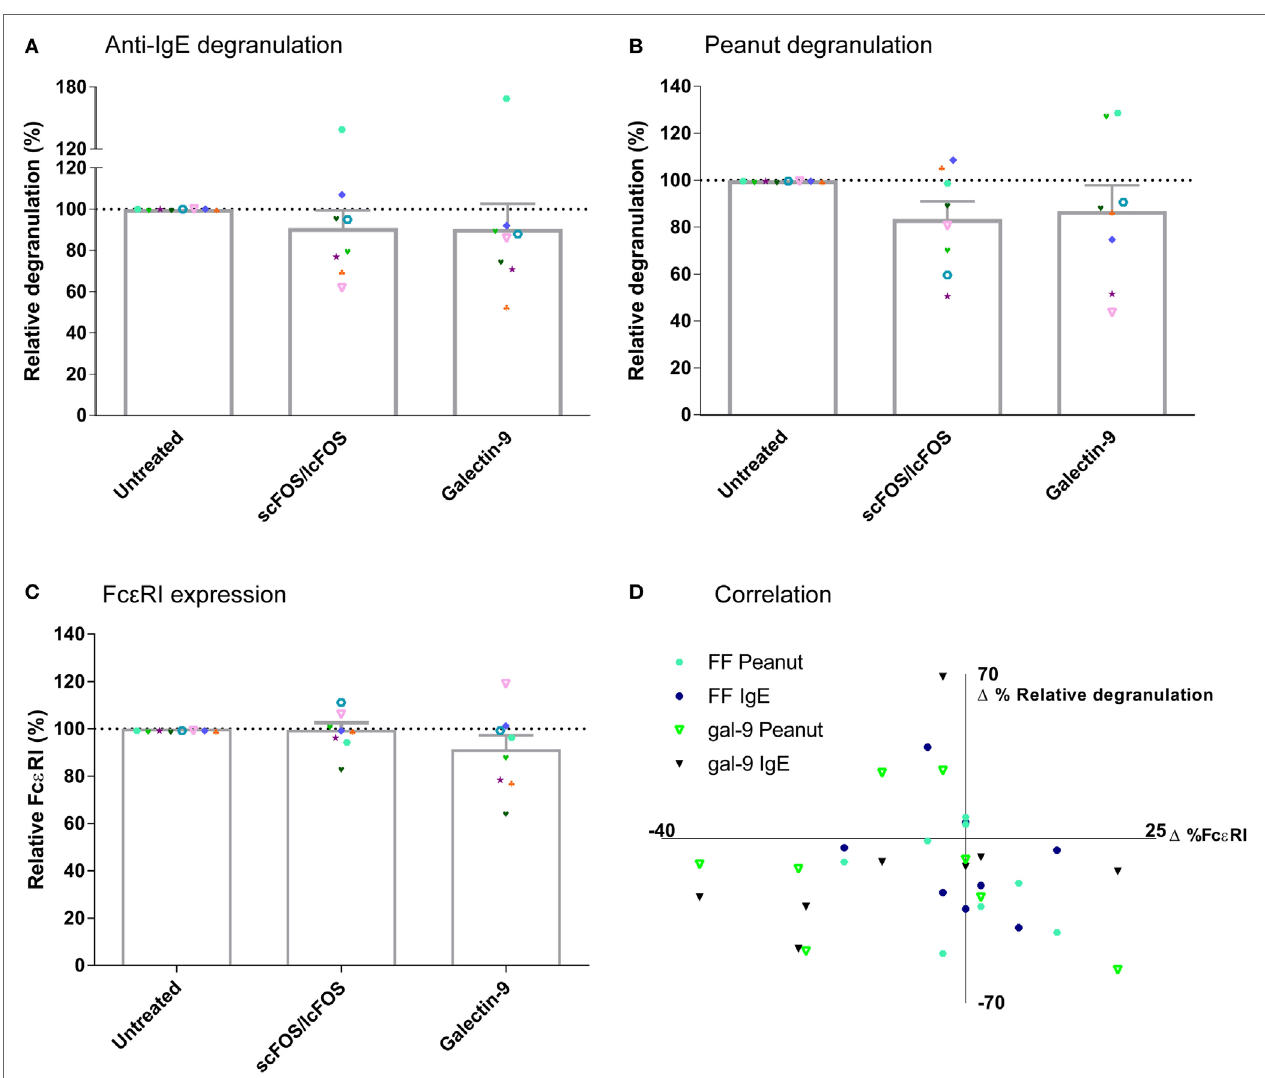
FigUre 3 | Correlation relative expression of Fc ε RI and basophil degranulation. Anti-IgE mediated and peanut-specific basophil degranulation after 24 h of pre-incubation with short- and long-chain fructo-oligosaccharides (scFOS/lcFOS) or galectin-9 (a,B) . Fc ε RI expression on basophils was not decreased after pre-incubation with scFOS/lcFOS or 1 µg/mL galectin-9 (c) . Δ % relative degranulation was calculated based on panels (a,B) , whereas Δ %Fc ε RI was calculated based on panel (c) , both relative to the control samples. No correlation was found between expression of Δ Fc ε RI on the cell surface and the corresponding Δ basophil degranulation (D) . (FF = scFOS/lcFOS). Data represent n = 8 patients. Correlation was tested with Pearson correlation